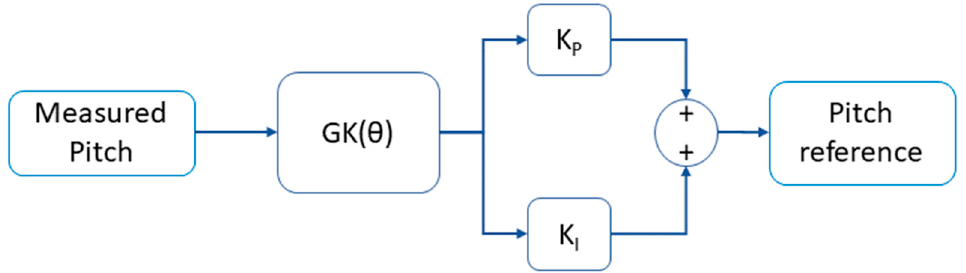
Figure 3. Diagram of the reference PI controller.